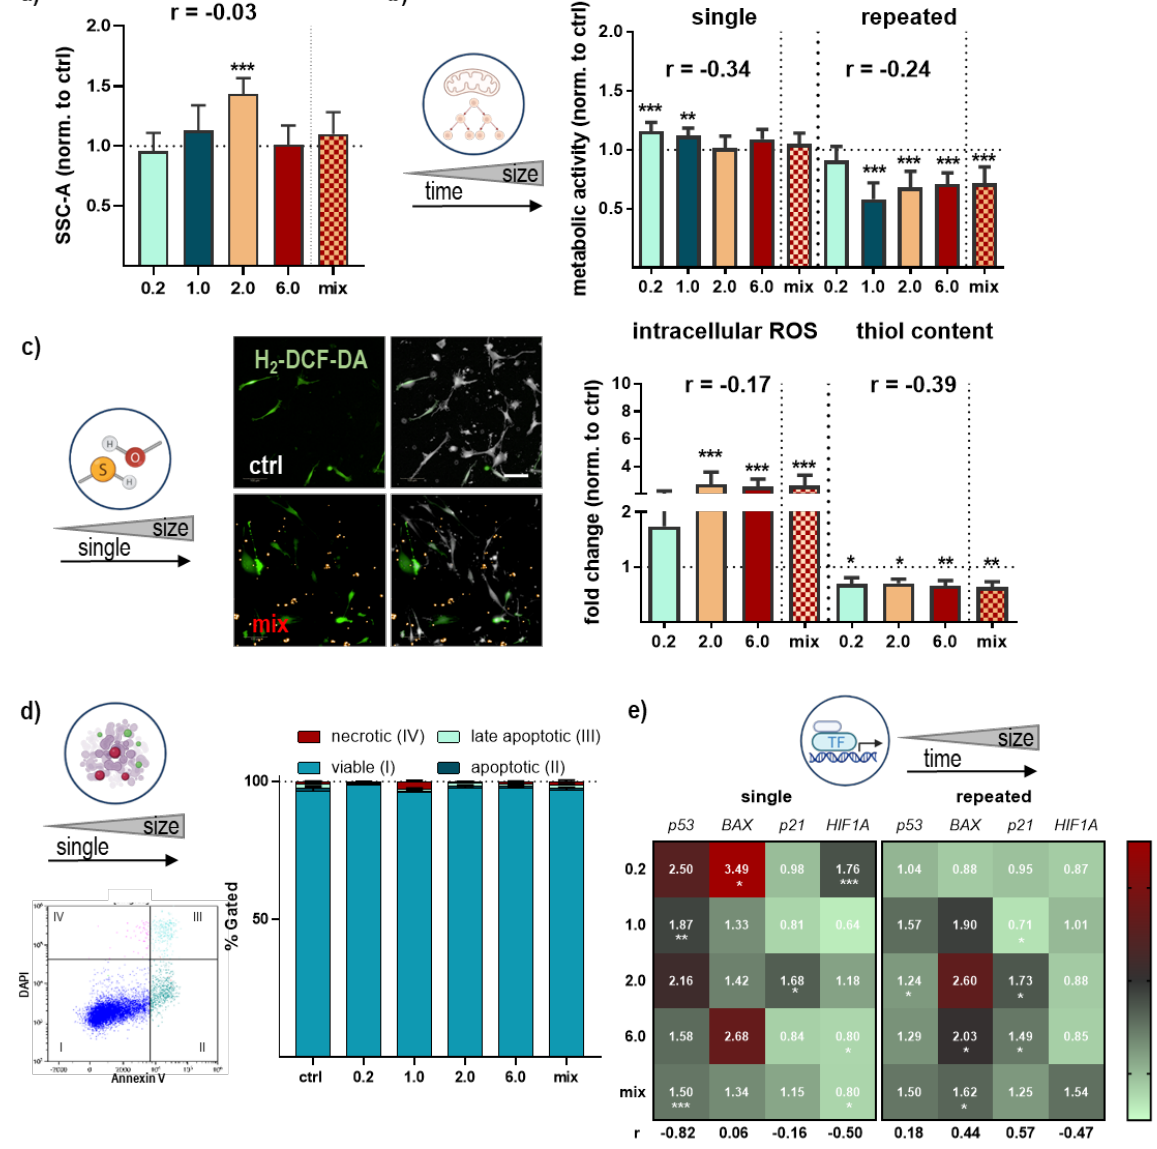
Figure 2. Cellular metabolism, intracellular ROS, thiol content, viability, and apoptosis in NMP- treated lung cells. ( a ) Quantification of side-scatter (SCC) signals from individual cells by flow cytometry analysis; ( b ) study scheme and metabolic activity of lung cells exposed to NMP after single or repeated treatment; ( c ) representative images of H 2 -DCF-DA staining in untreated (ctrl) and NMP-treated lung cells (mix) and quantification of ROS by high-content image as well as thiol content analysis using flow cytometry; ( d ) representative FACS density-plot of untreated lung cells; determination of viable and early and late apoptotic and necrotic cells after FITC-Annexin V and DAPI staining using flow cytometry; ( e ) heatmaps of quantification of apoptosis-related p53 and BAX mRNA, cell-cycle-related p21 mRNA, and HIF1A mRNA after single (left) and repeated (right) treatment using qPCR. Data were normalized to GAPDH / RLP13A and untreated controls (ctrl) and presented as mean + SE. Statistical analysis was done by unpaired, two-tailed Student ’s t-test ( n > 3) with * p < 0.05, ** p < 0.01, and *** p < 0.001. Scale bar is 50 µm (c). Table 1. Pearson (r) correlation coefficients for several types of analyses for single and repeated NMP effects with the goal of identifying statistical relations between plastic particle sizes and biological effects observed, sorted for descending r-values, showing gene expression after single exposure (top left), gene expression after repeated exposure (top right), protein expression after single (bottom left) repeated (middle bottom right) exposure, and cellular processes (bottom right) such as uptake, metabolic activity, ROS, and thiol content.